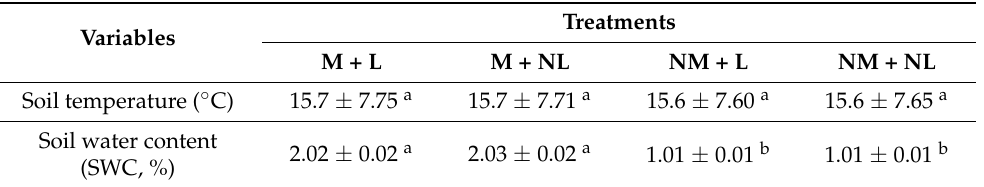
Table 3. Soil temperature and water content (mean ± standard deviation) after post-fire treatments in Sierra de Los Donceles forest (Li é tor, Castilla La Mancha,